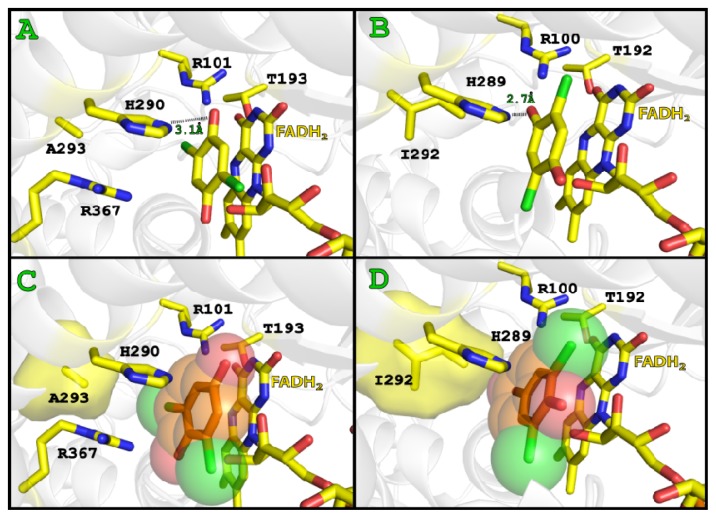
(a) TcpA with docked FADH2 and 2,5-DiCHQ (b) TftD with docked FADH2 and 2,5-DiCHQ (c) TcpA with docked FADH2 and 2,6-DiCHQ (d) TftD with FADH2 and docked 2,6-DiCHQ.